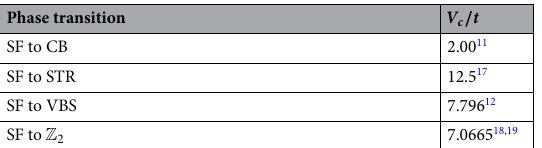
is not included) corresponding to geometric braids belonging to B N ′ ( S ) . By only considering the fraction of particles involved in PC longer than 1 β , it is possible to better compare the arrangement of permutation cycles in different ground-states. Finally, we introduce a topological invariant which can be interpreted as an ‘average’ length of PC useful to order and label different (cid:31) p φ :